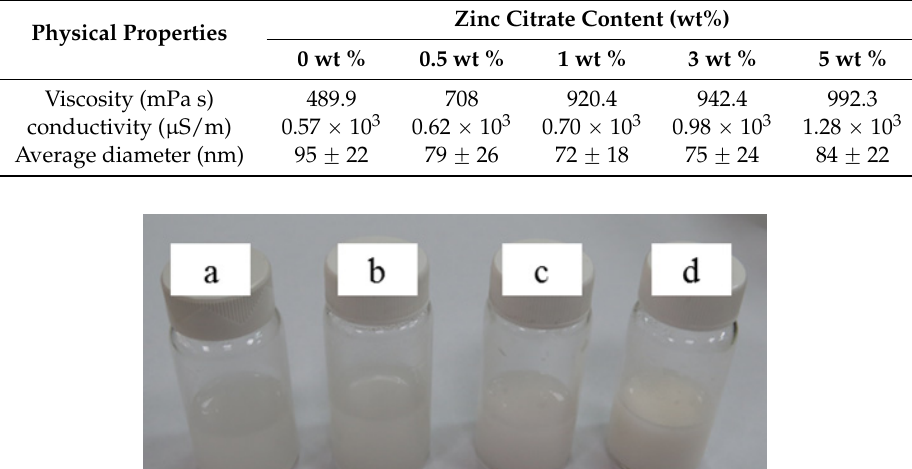
Table 1. Viscosity of polyvinyl alcohol (PVA)/zinc citrate mixtures and specification of nanofiber mats.